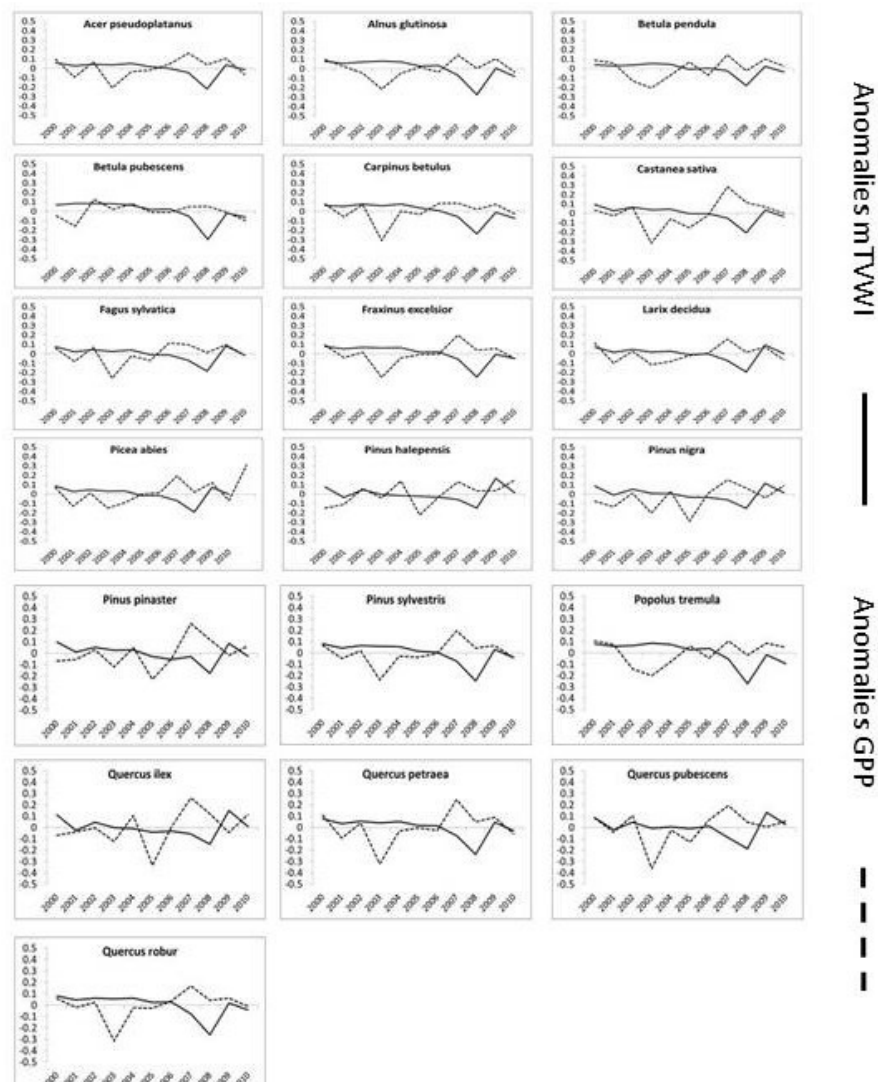
Figure 10. Anomalies of mTVWI and GPP over the time period 2000–2010. The term anomaly is defined here as the difference between the mean of mTVWI and GPP calculated for a single year and the grand–mean of mTVWI and GPP but considering the overall time period